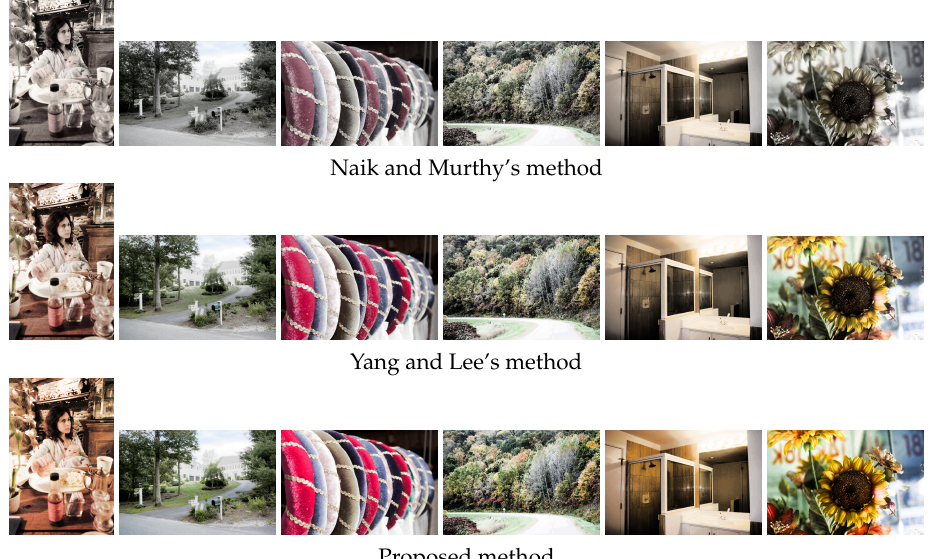
Figure 13. Histogram equalization applied to color images in Figure 12, where the top, middle and bottom rows show the output images by Naik and Murthy’s, Yang and Lee’s and the proposed methods, respectively.